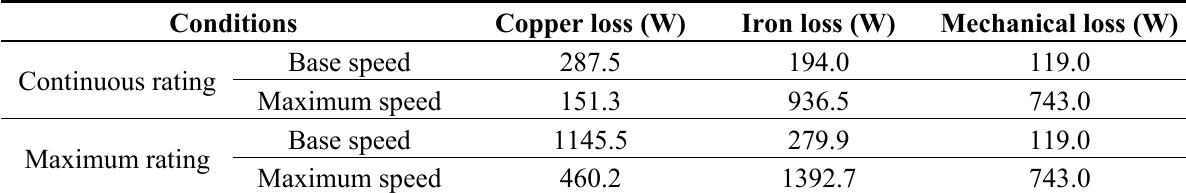
Table 1. Heat generated under various conditions.